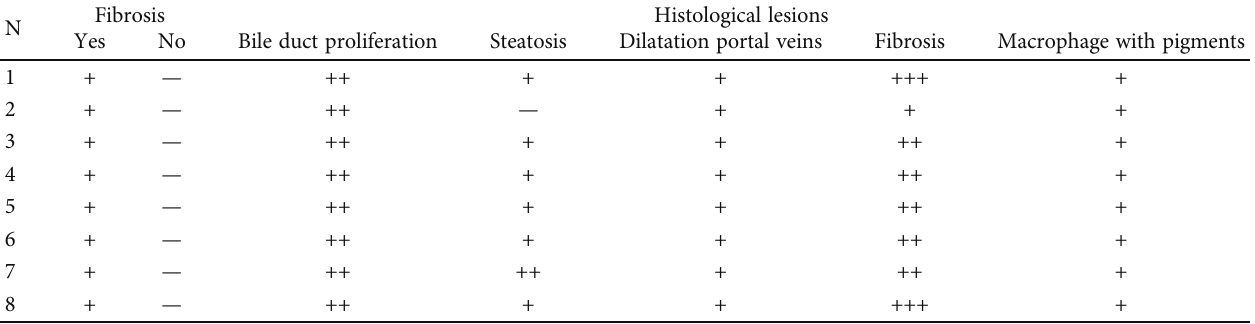
Table 2: Grading of histological lesions present in group G-II liver fi